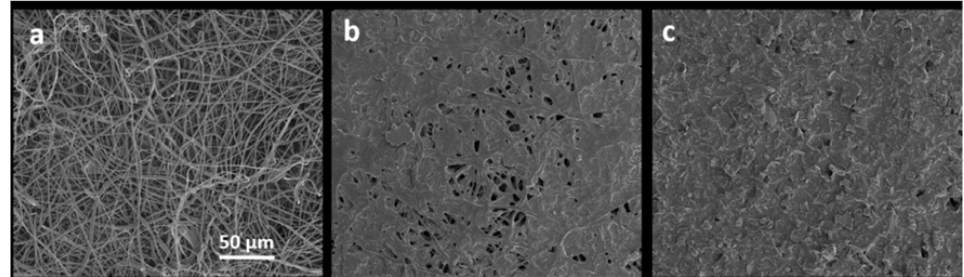
Figure 3. SEM and profile images of ( a ) the copolyamide (coPA) electrospun mat, ( b ) the coPA mat covered by SL ‐ Ti 3 C 2 T x , and ( c ) the coPA mat covered by ML ‐ Ti 3 C 2 T x. In the next step, electrospun coPA mats were covered with ML ‐ or SL ‐ Ti 3 C 2 T x by vacuum filtration. Due to the high porosity of the coPA membranes, some of the Ti 3 C 2 T x particles penetrated into the 3D structure of the coPA mat, and some of them passed through the mat. The neat coPA mat and the covered coPA membrane are displayed in Figure 4. The Ti 3 C 2 T x particles were distributed homogenously onto the coPA membrane, as shown in Figure 4b.